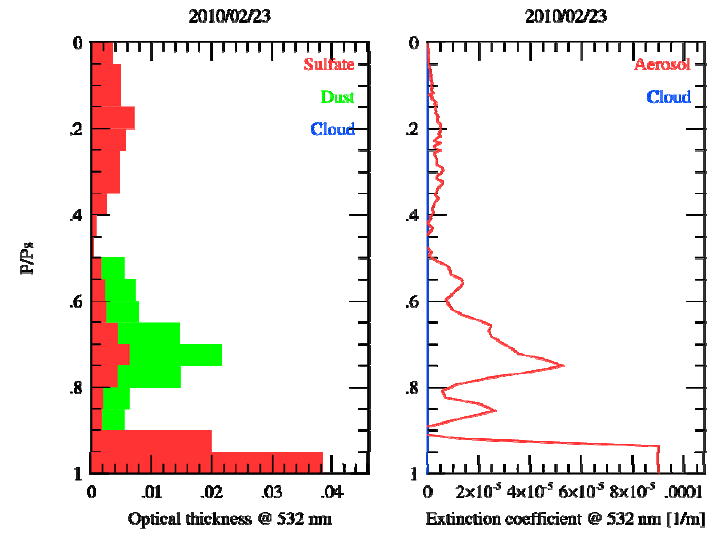
Fig. 4. Vertical profiles of optical thicknesses (left panel) and extinction coefficients (right panel) of sulfate and dust particles at 532nm on 23 February Fig. 4.